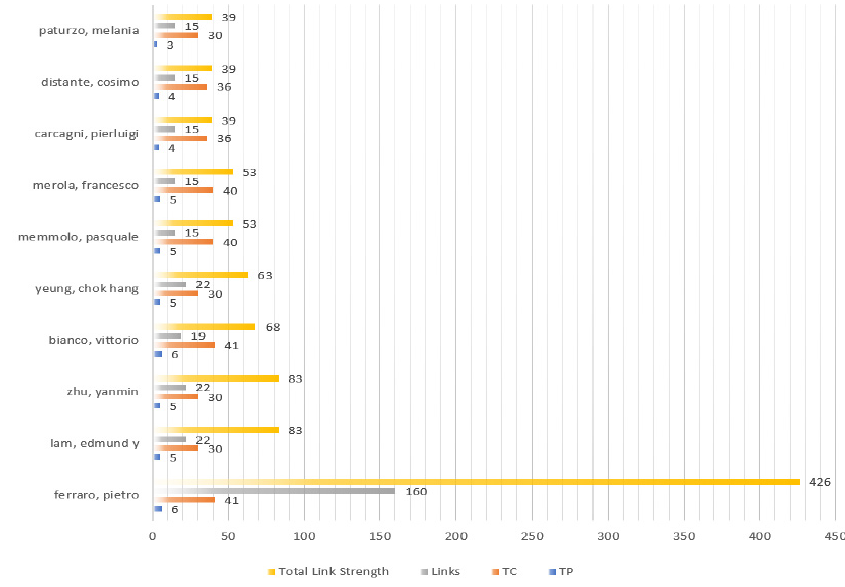
Figure 15. The most active citation